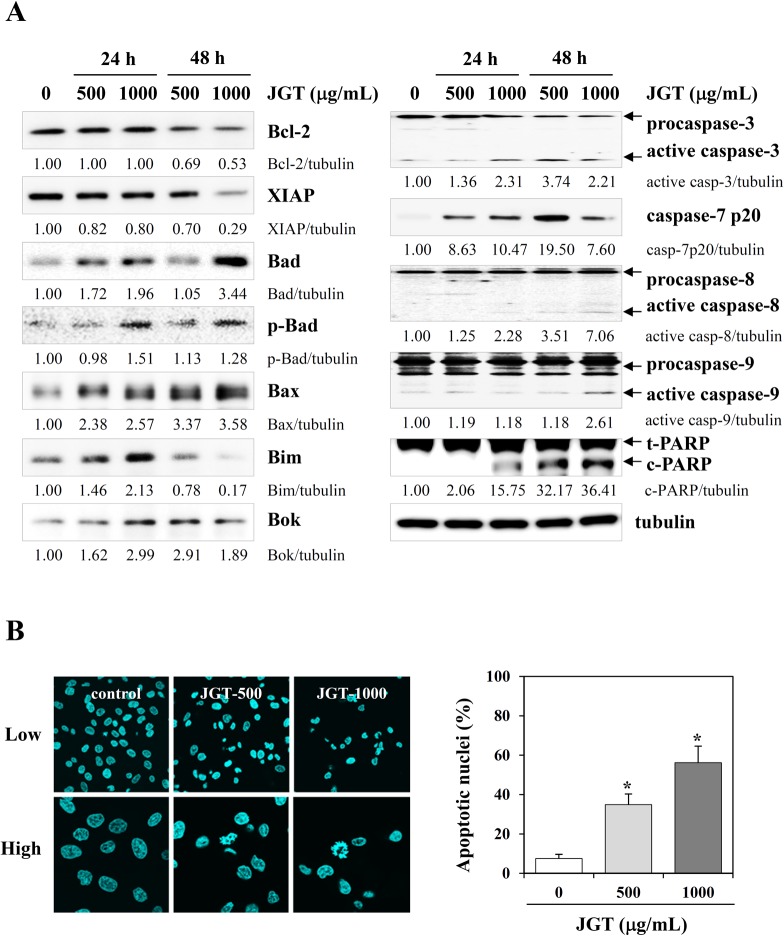
JGT induces apoptotic cell death.
(A) HT1080 cells were treated with 500 and 1000 μg/mL JGT for 24 and 48 h, and the levels of cell death-related proteins were examined by Western blotting. The band intensities relative to untreated cells were calculated using ImageJ software after normalization to tubulin expression. (B) For the detection of apoptotic nuclei, cells treated with 500 and 1000 μg/mL JGT for 48 h were stained with DAPI and observed under a confocal microscope. Data are representative of three independent experiments, and expressed as means ± SD of 5 random fields per sample. * p < 0.05 vs. untreated control.